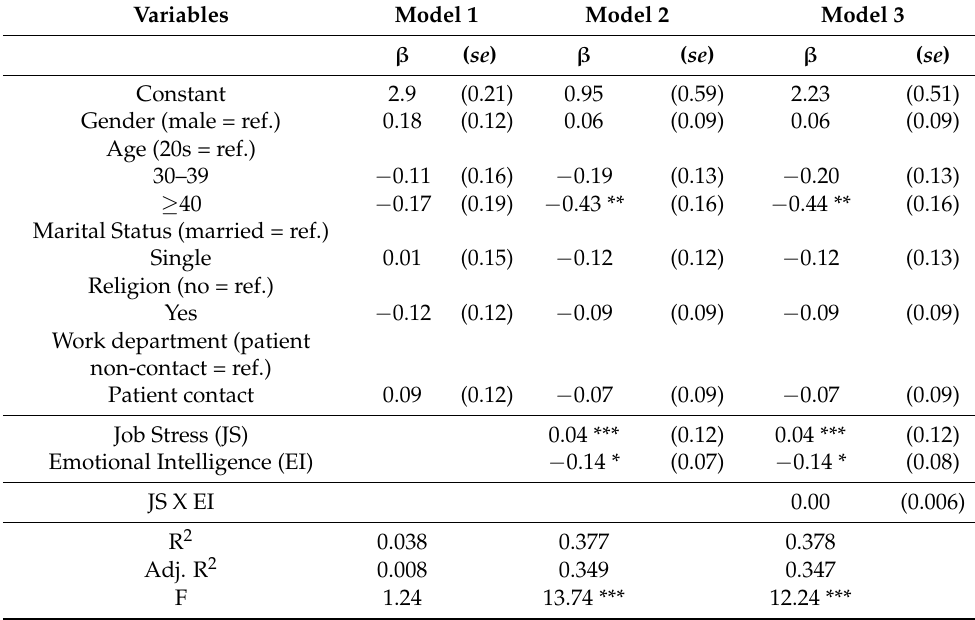
Table 4. Influencing factors on burnout ( N =